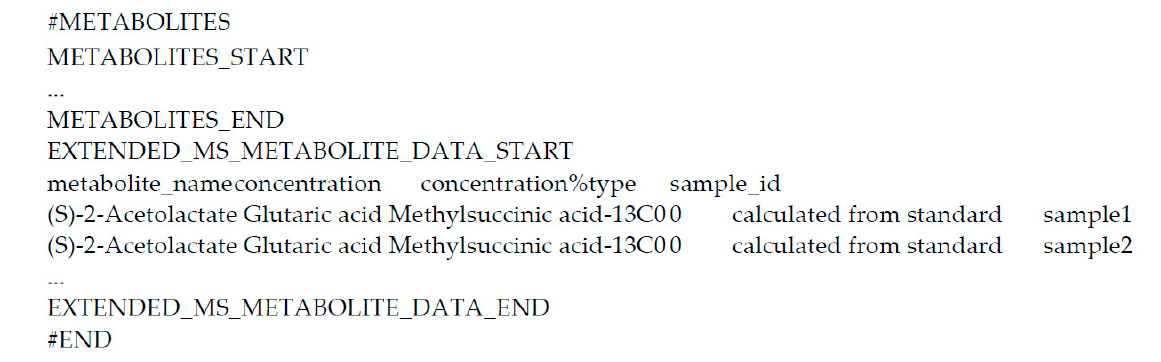
Figure 4. Overview of an ‘EXTEND_MS_METABOLITE_DATA’ section in the ‘METABOLITES’ block of an example ‘mwTab’ file.